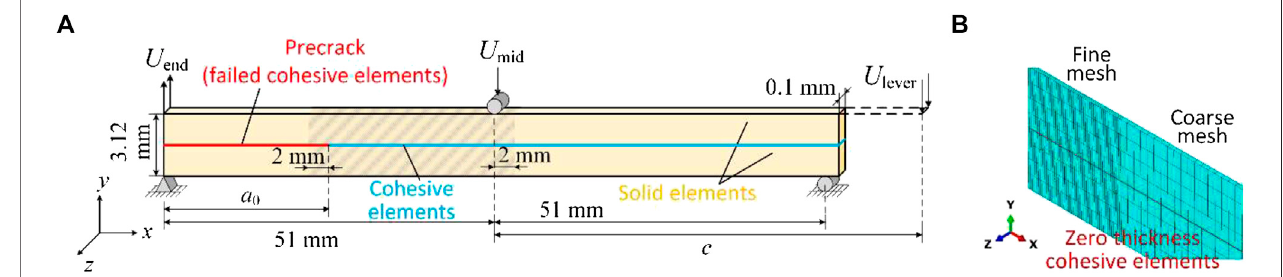
FIGURE 4 | Modeling MMB specimen in FEM: (A) geometry of the model and boundary conditions; (B) zoom-in view of the mesh.